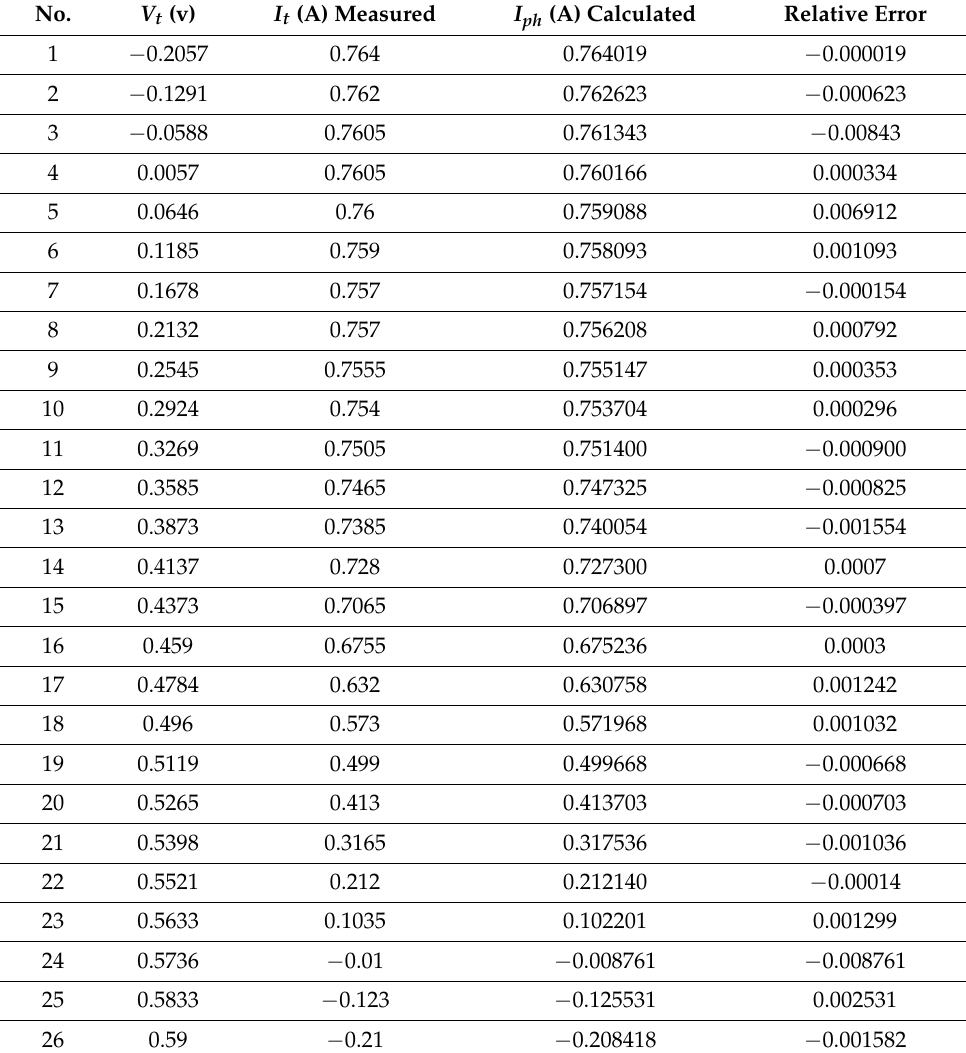
Figure 9. Measured current vs. calculated by CEHO. ( a ) single diode. ( b ) double diode. Table 6. The relative error for 26 measurements (double diode) with CEHO. No. V t (v) I t (A)